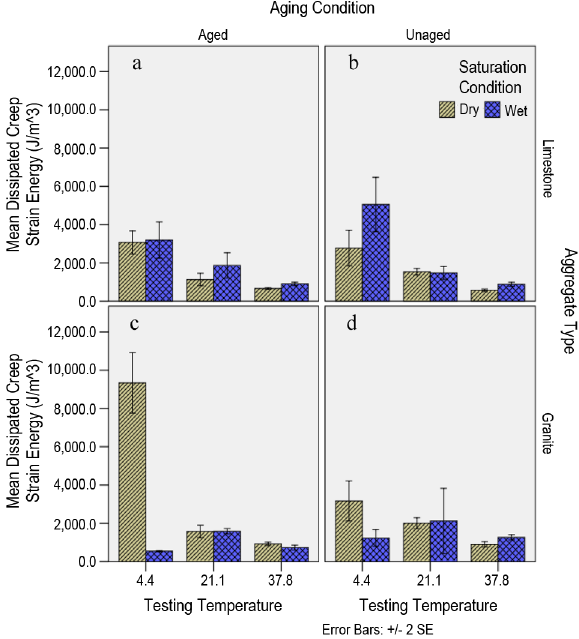
Fig. 8. Dissipated creep energy of: a) limestone aged mixtures; b) limestone un-aged mixtures; c) granite aged